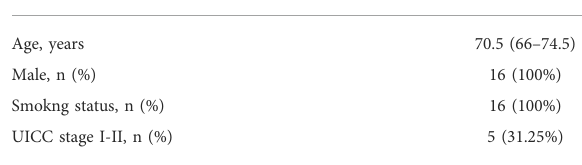
TABLE 2 Clinical characteristic of 16 paired lung tissue from patients with NSCLC.